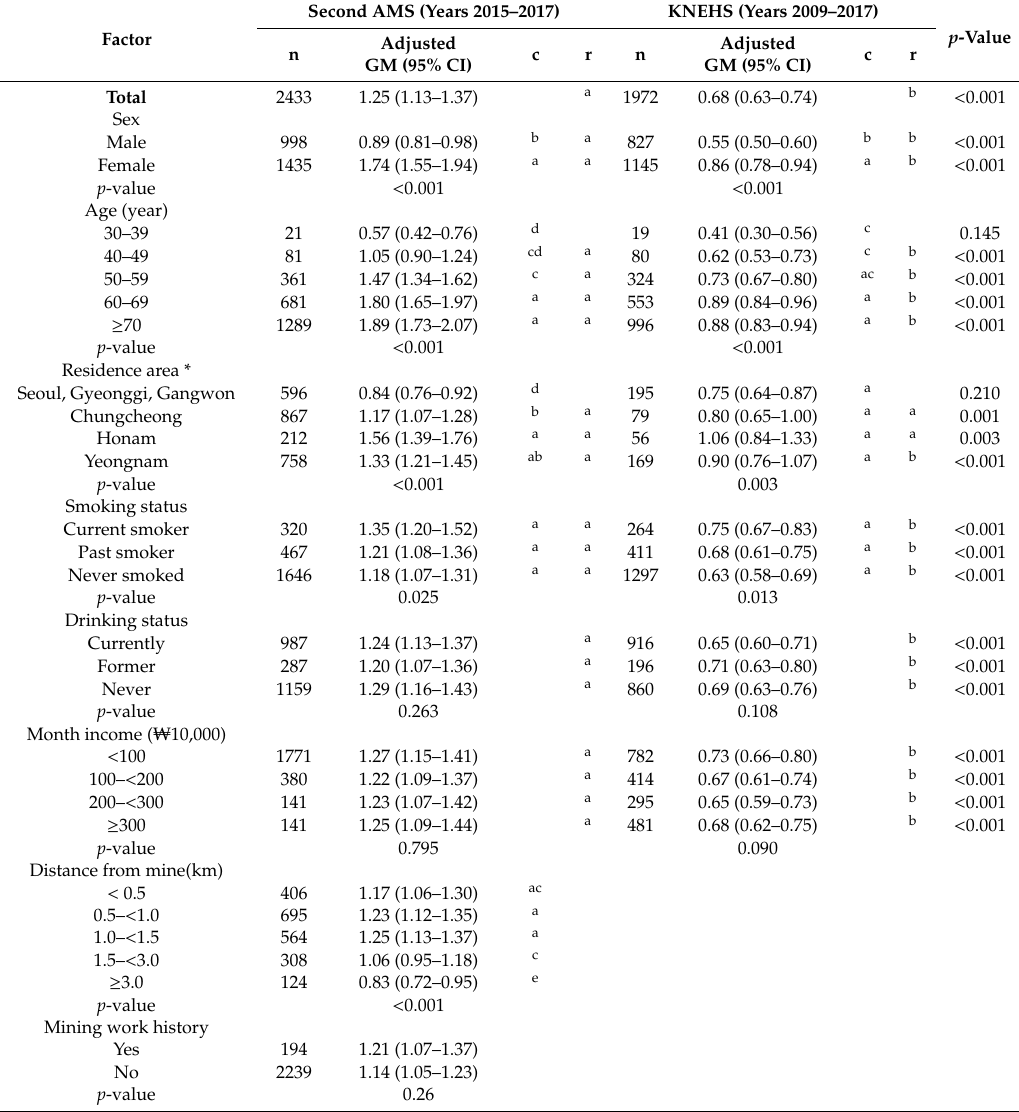
Table 4. Adjusted geometric means of the urine cadmium (Cd) concentration ( µ g / g